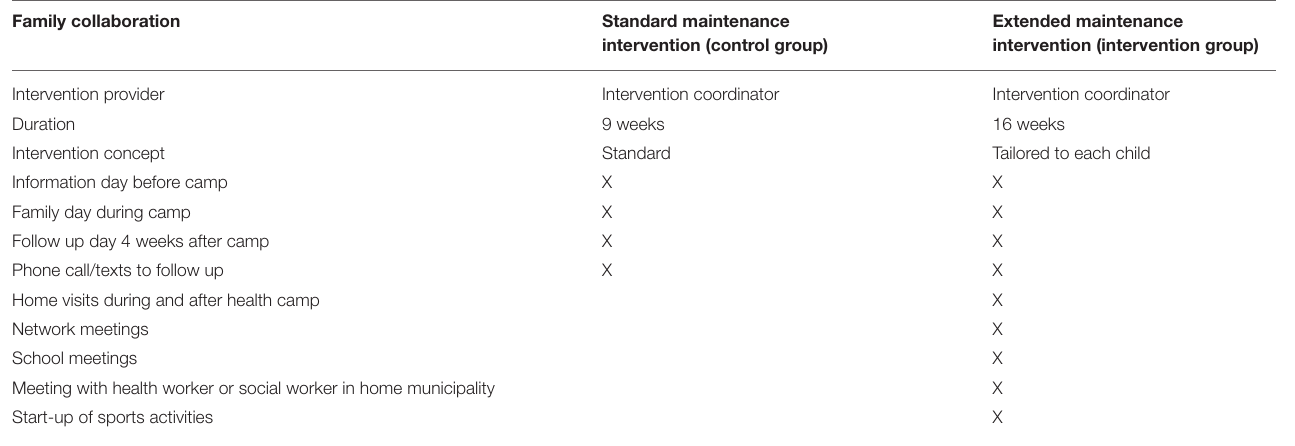
TABLE 1 | Main similarities and differences between the two maintenance